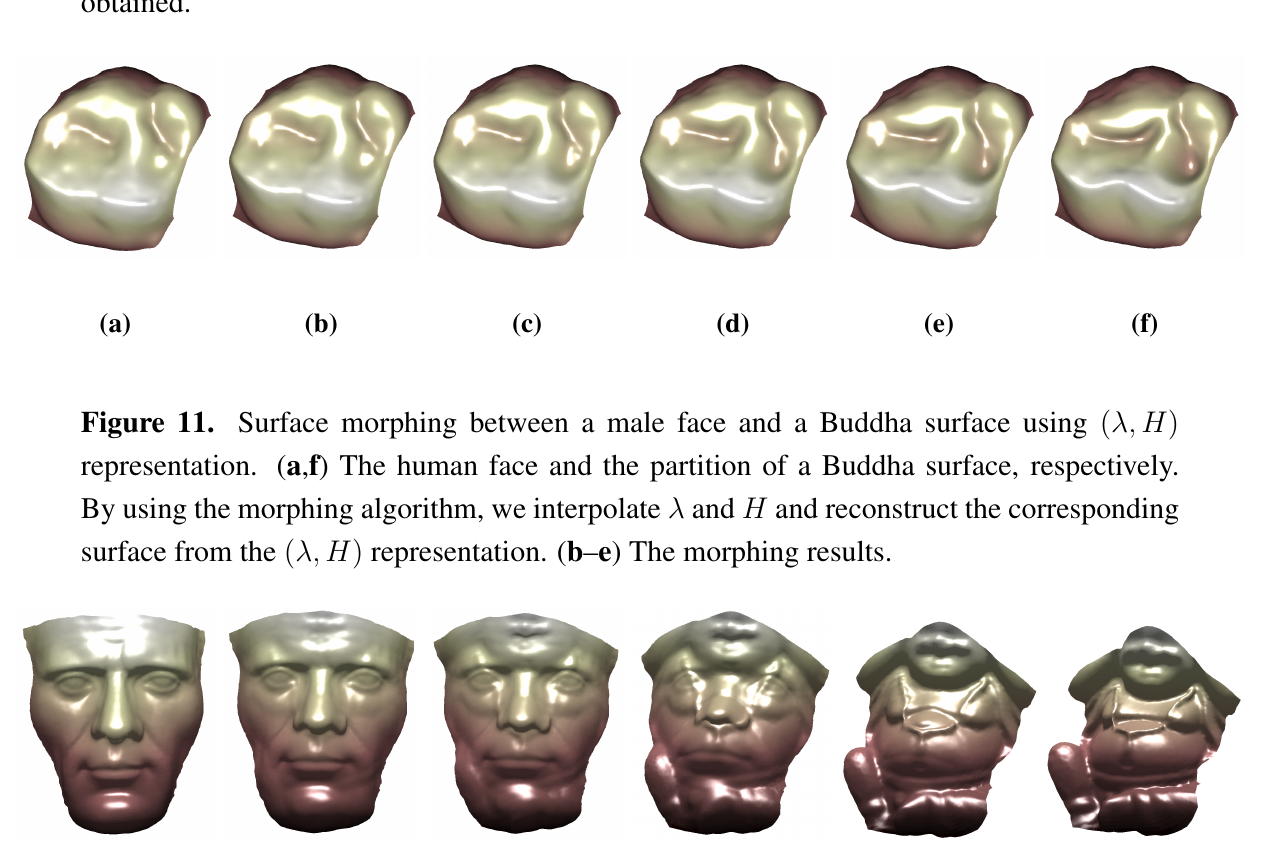
Figure 10. Surface morphing between two teeth using ( λ, H ) representation. ( a , f ) Tooth 1 and Tooth 2, respectively. By using the morphing algorithm, we interpolate λ and H and reconstruct the corresponding surface from the ( λ, H ) representation. ( b – e ) The morphing results. Note that a natural evolution of ridges and valleys from Tooth 1 to Tooth 2 is obtained.